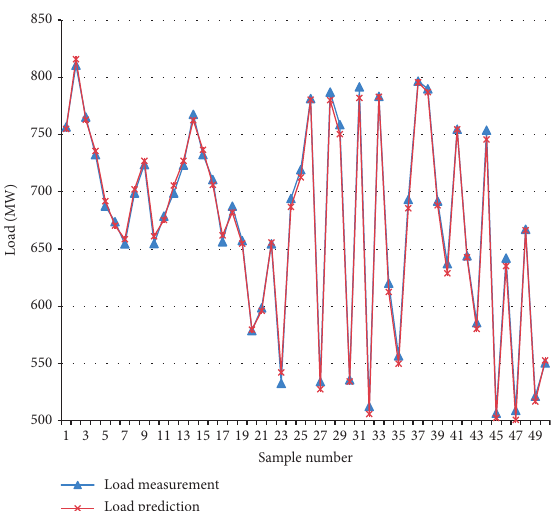
Figure 2: Comparisons and load measured value.